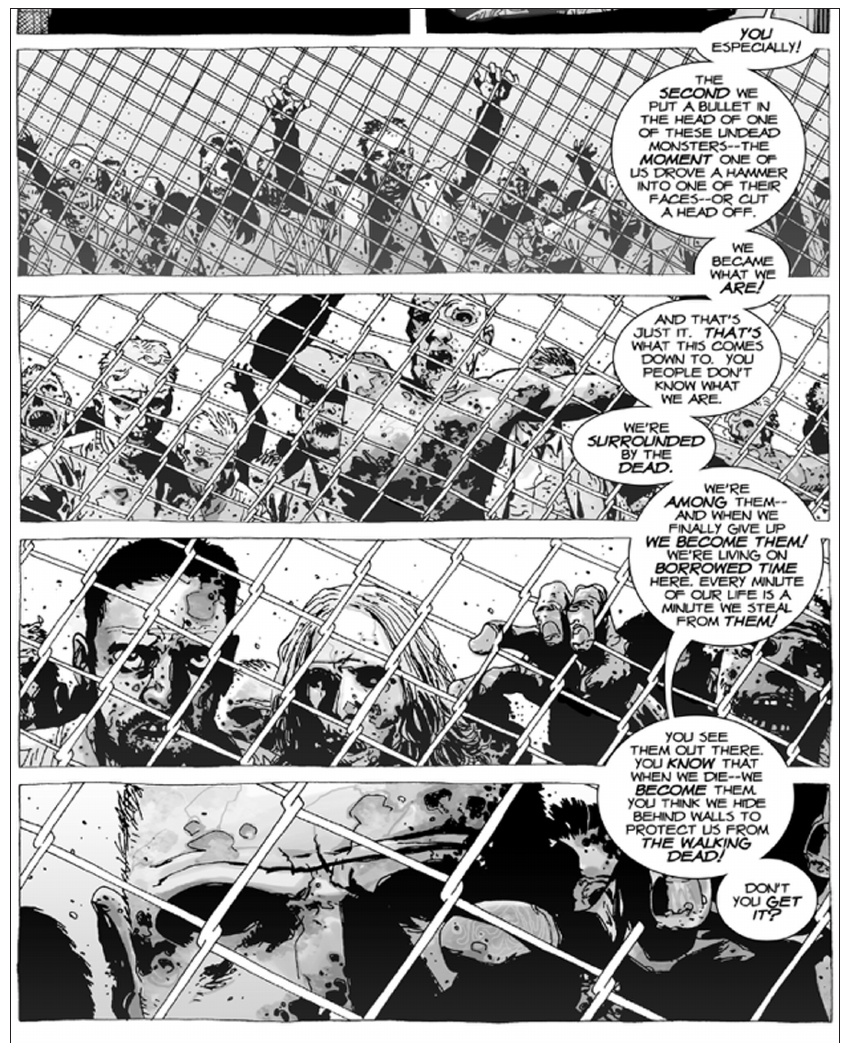
Figure 2: Kirkman, Robert (w) and Charlie Adlard (a). Page from Kirkman, R. 2007. The Walking Dead : Book 2. © 2007 Image